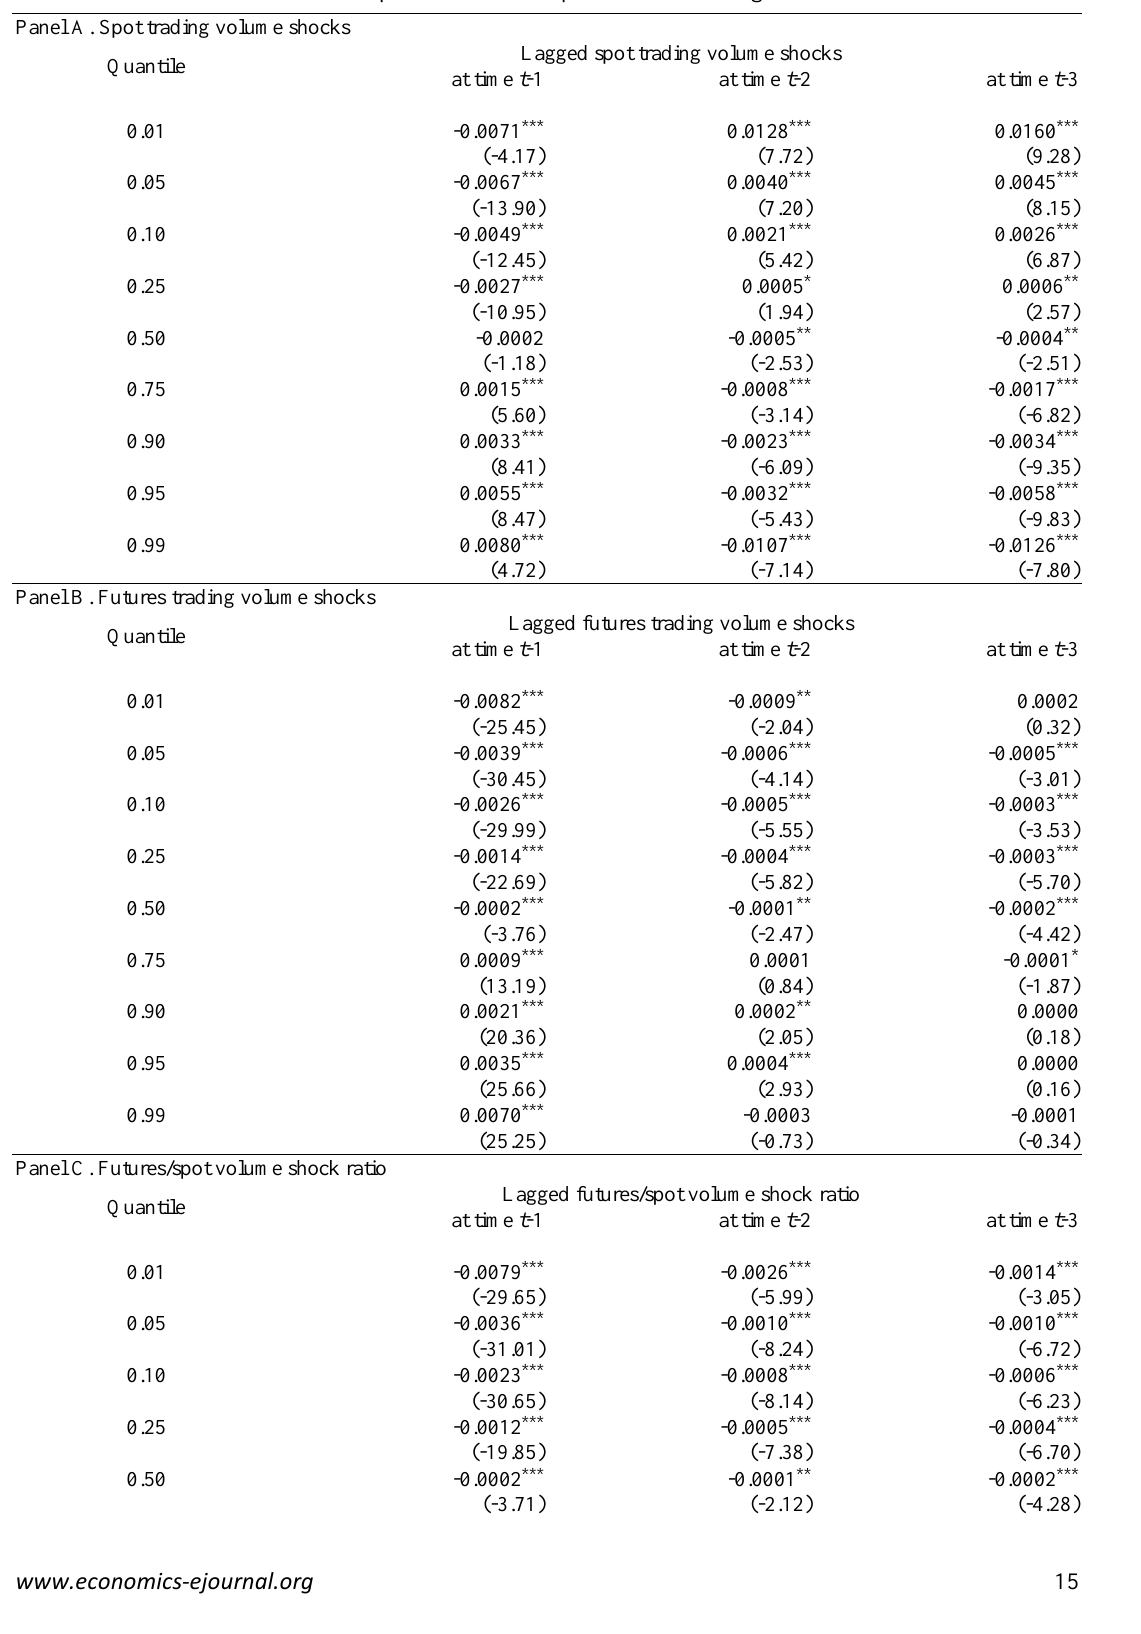
Table 3: Relationship between return quantiles and trading volume